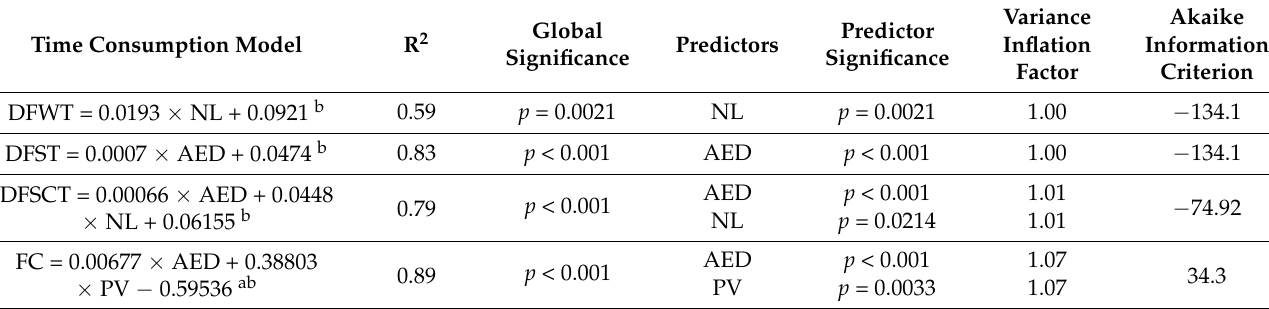
Table 7. Time and fuel consumption dependence